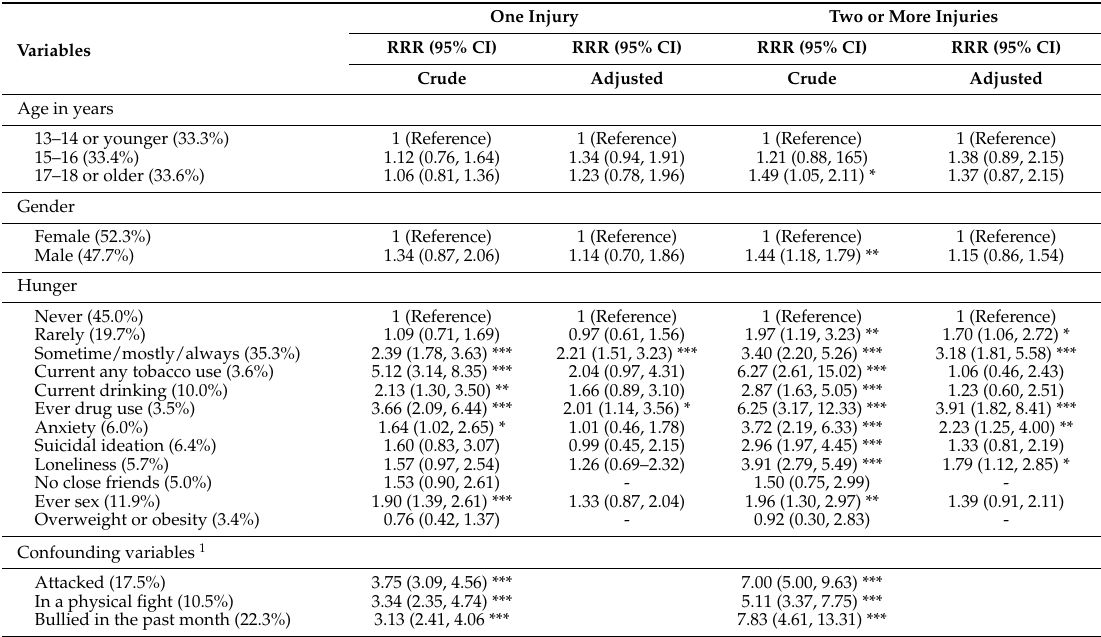
Table 4. Relative risk ratios and 95% confidence intervals from a multinomial logistic regression model predicting one injury and two or more injuries in